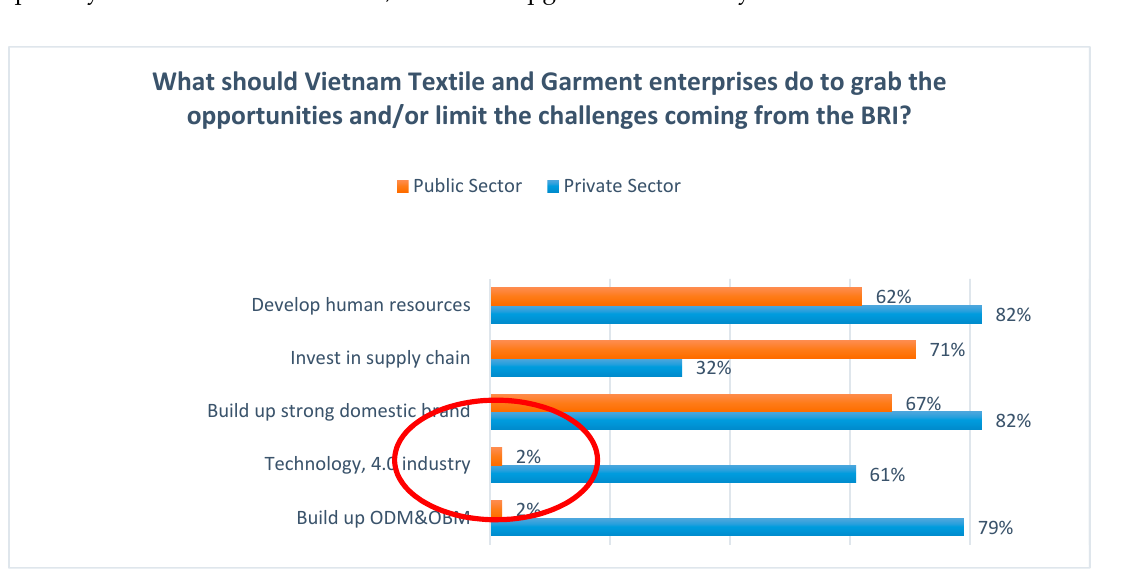
Figure 7. Expected actions taken by Vietnam (Source: Authors’ analysis).